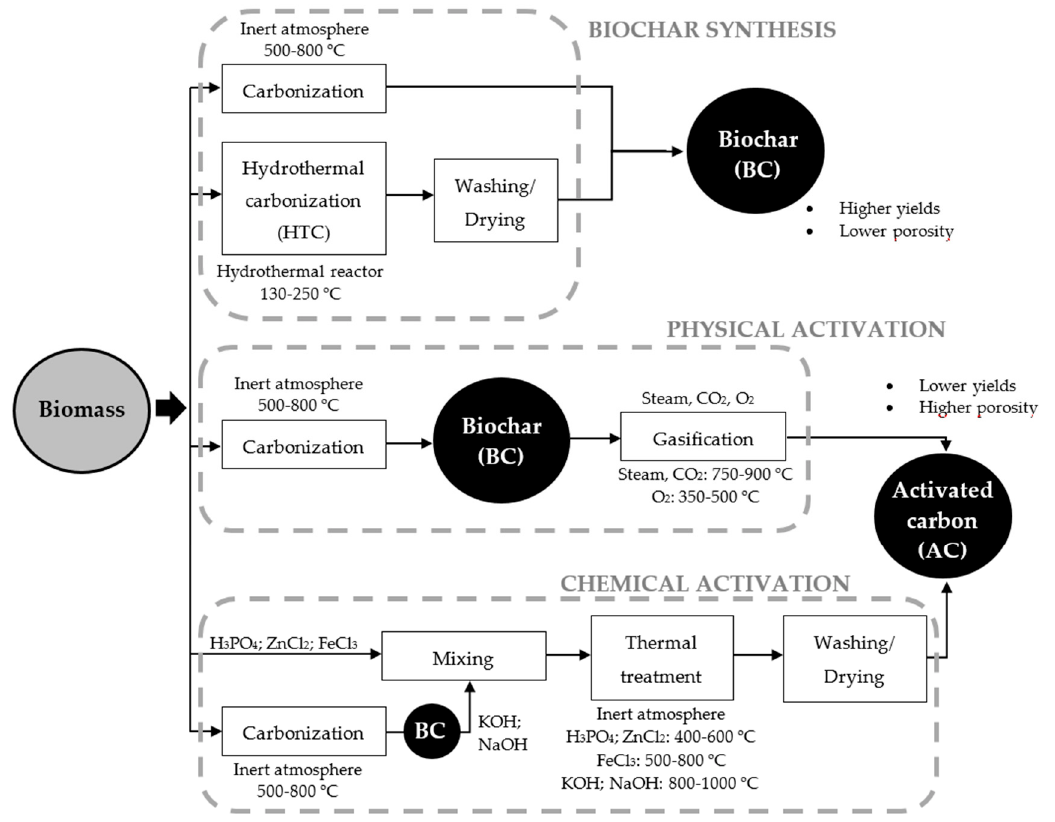
Figure 3. Synthesis routes to biochars and activated carbons from biomass.